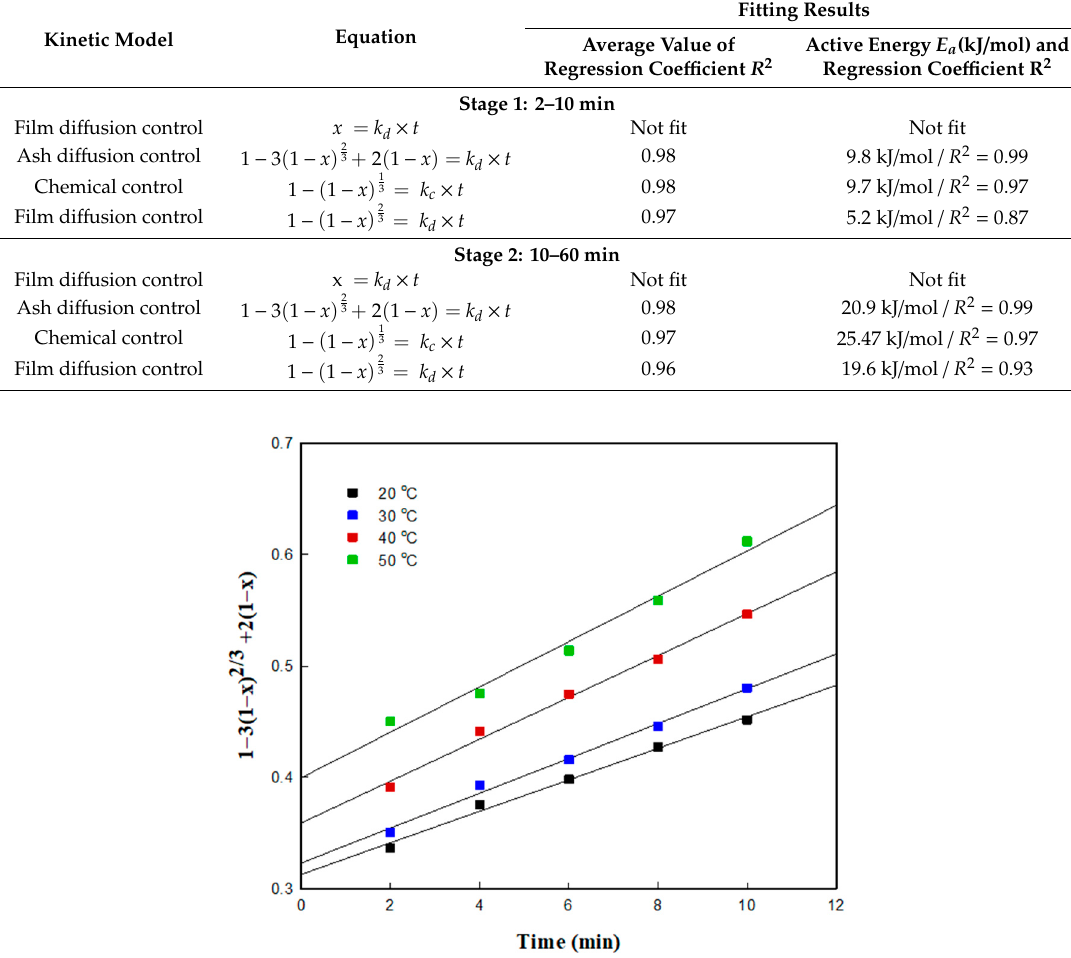
Figure 9. Plot of (cid:4670) 1  3(1  x ) 2 3 (cid:3415) + 2(1  x )] versus leaching time (10–60 min) at different temperatures.